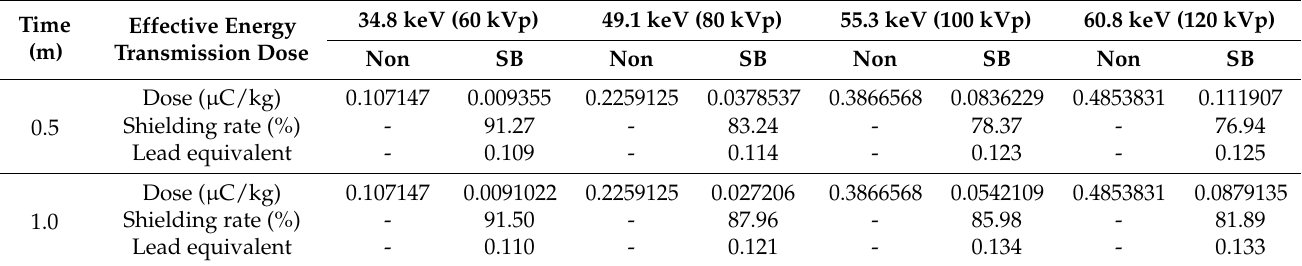
Table 4. Comparison of shielding performance based on the mixing time of the same